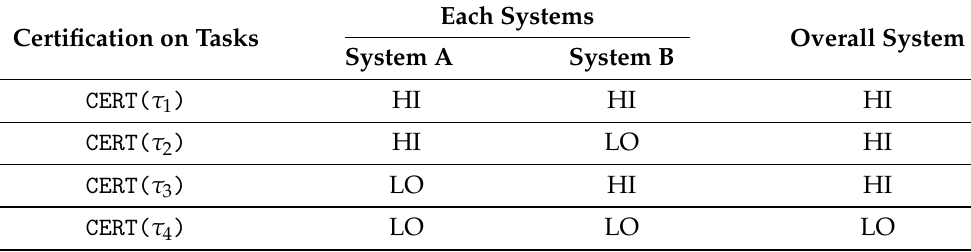
Table 7. Certification of overall distributed